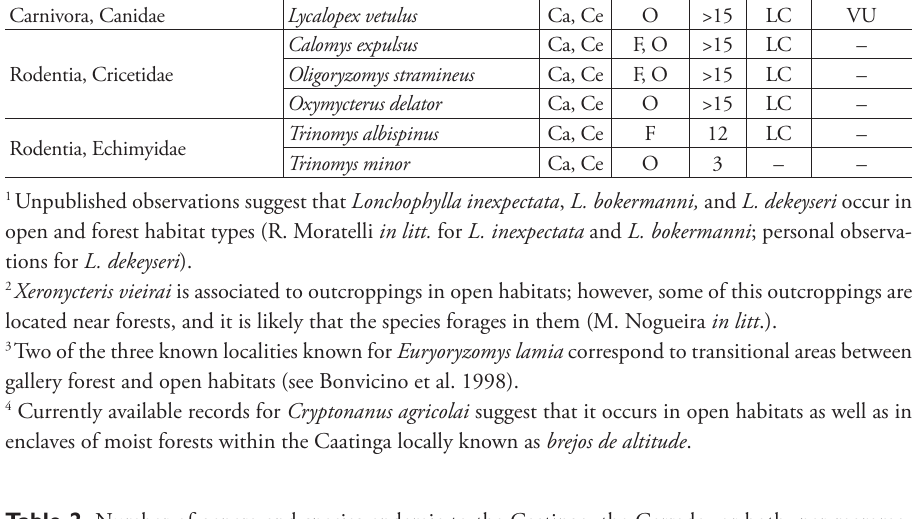
Table 2. Number of genera and species endemic to the Caatinga, the Cerrado, or both, per mamma- lian order. The column “Caatinga-Cerrado” corresponds to endemic taxa with presence in both biomes, whereas the column “all endemics” corresponds to taxa either endemic to the Caatinga, or to the Cerrado, or endemic to both in